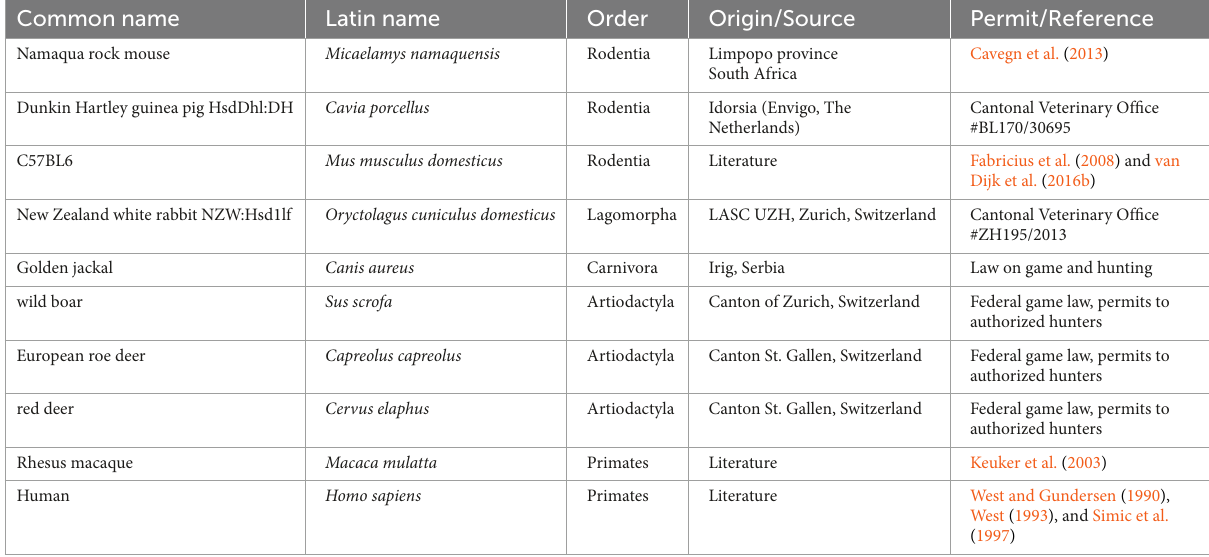
TABLE 1 List of species, their latin names, orders, sources, and permits or